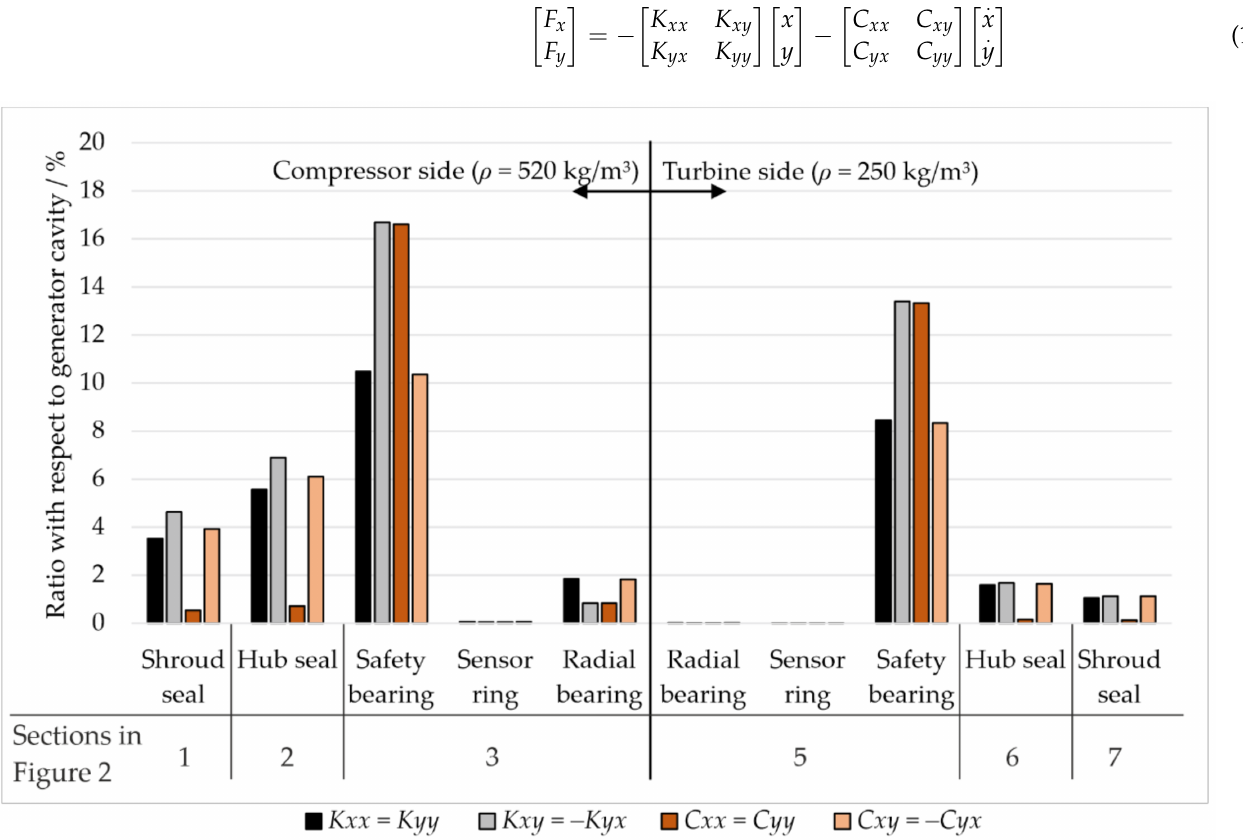
Figure 4. Ratio of stiffness coefficients ( K ) and damping coefficients ( C ) with respect to coefficients of generator cavity (density = 310 kg/m 3 ) calculated for flow path configuration